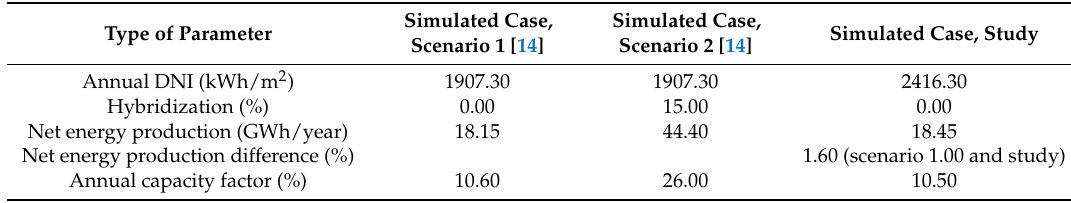
Table 3. Parameters of the model validation.